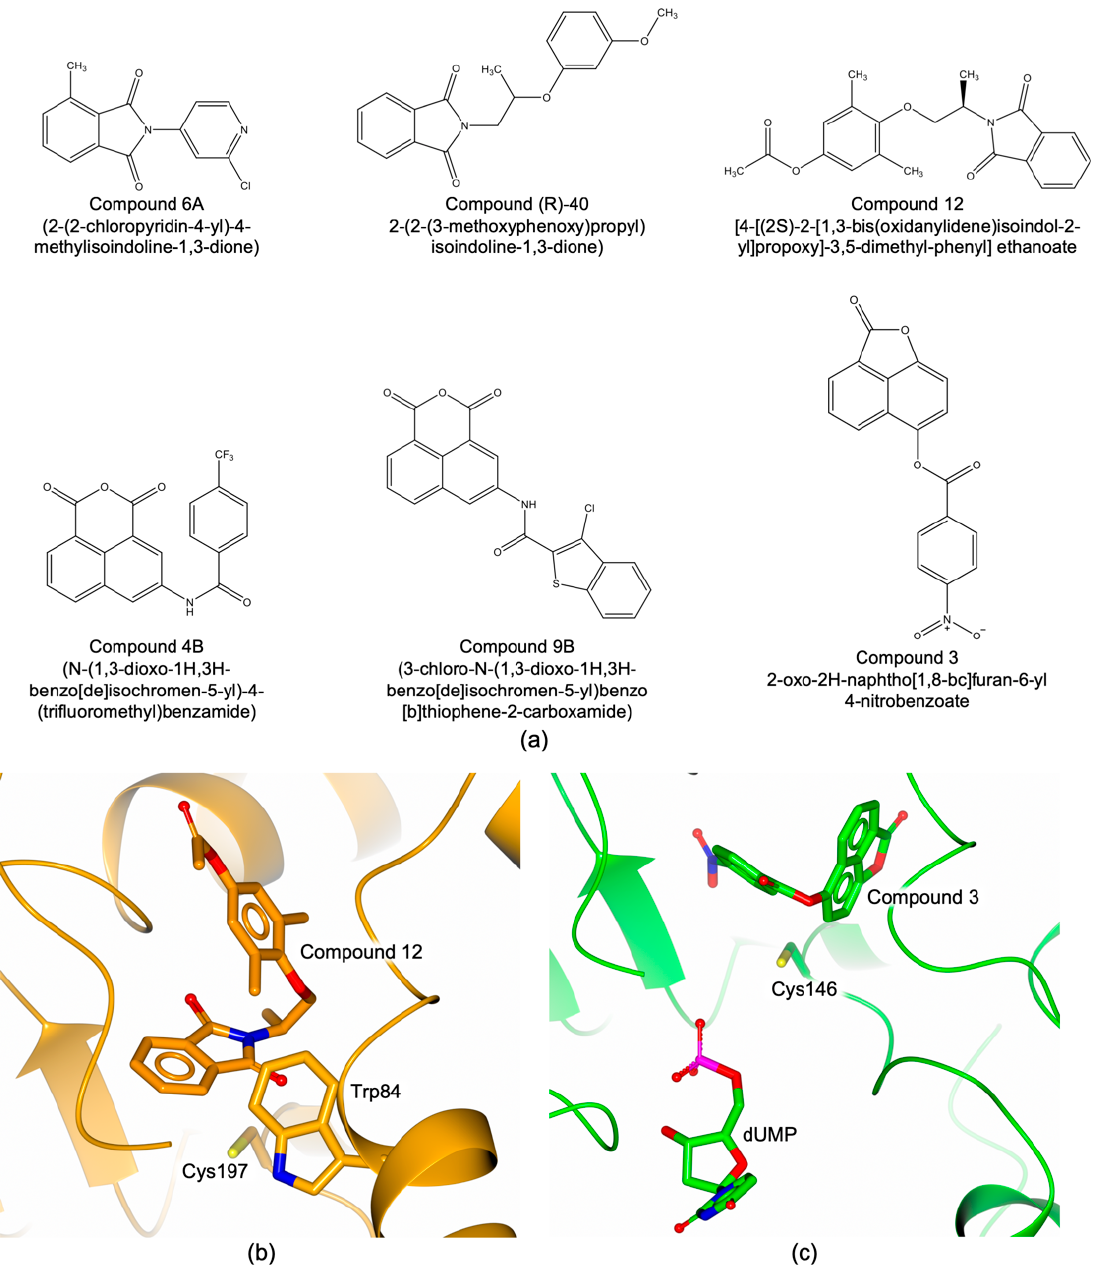
Figure 6. ( a ) Chemical structure of bTS inhibitors. ( b ) Binding mode of Compound 12 (in sticks, orange carbons) within the active site of Ef TS (orange cartoon and carbons) (PDB id 4O7U [50]). ( c ) Binding mode of Compound 3 (in sticks, green carbons) within the active site of Ec TS (green cartoon and carbons; dUMP in sticks) (PDB id 4LRR [52]).